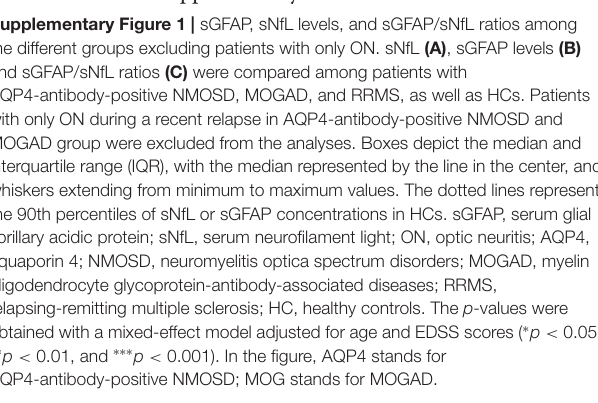
Supplementary Figure 1 | sGFAP, sNfL levels, and sGFAP/sNfL ratios among the different groups excluding patients with only ON. sNfL (A) , sGFAP levels (B) and sGFAP/sNfL ratios (C) were compared among patients with AQP4-antibody-positive NMOSD, MOGAD, and RRMS, as well as HCs. Patients with only ON during a recent relapse in AQP4-antibody-positive NMOSD and MOGAD group were excluded from the analyses. Boxes depict the median and interquartile range (IQR), with the median represented by the line in the center, and whiskers extending from minimum to maximum values. The dotted lines represent the 90th percentiles of sNfL or sGFAP concentrations in HCs. sGFAP, serum glial fibrillary acidic protein; sNfL, serum neurofilament light; ON, optic neuritis;